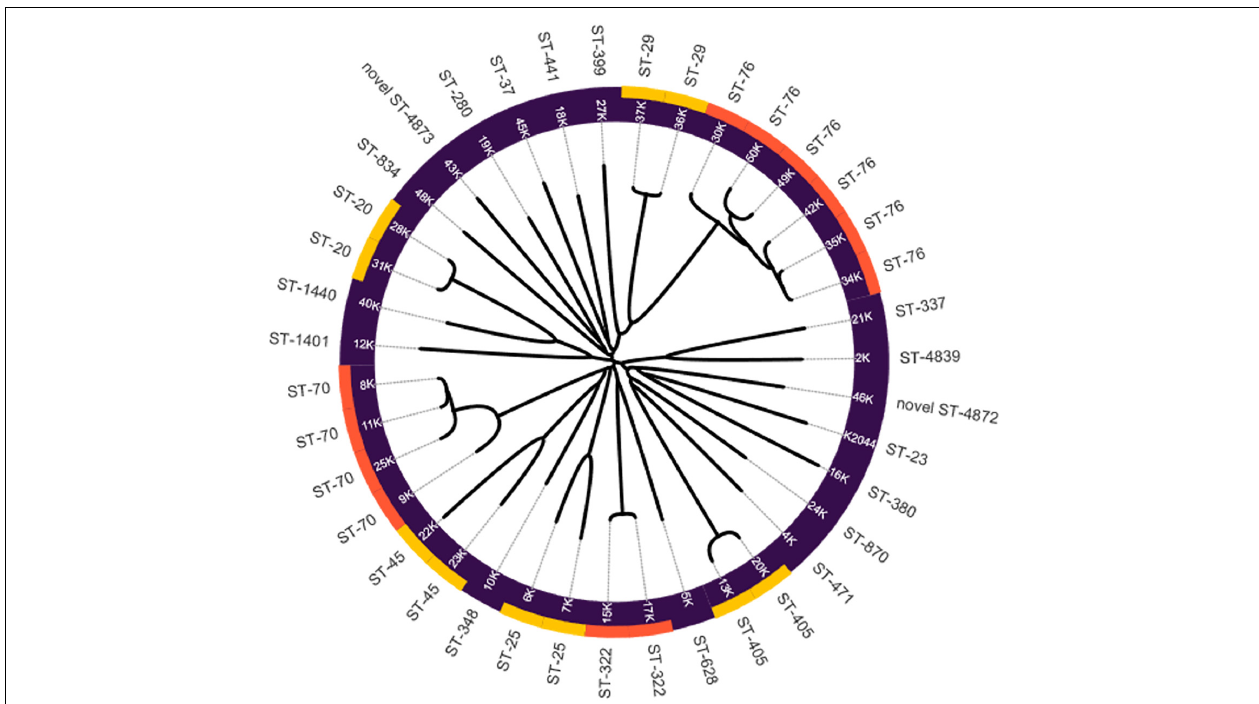
FIGURE 1 | Phylogenomic reconstruction of Klebsiella pneumoniae strains by VGF. NTUH-K2044 strain was added as reference. Yellow and orange colors denote the clustering of strains by